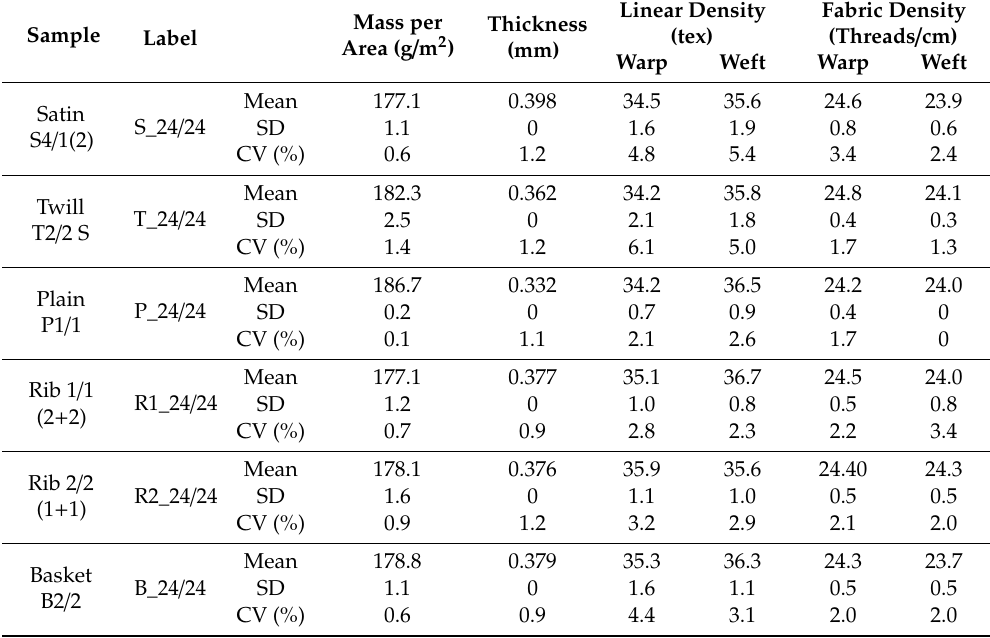
Table 2. Constructional / physical parameters of samples with density 24 / 24 threads / cm.